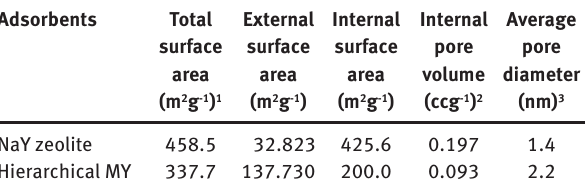
Table 2: Surface area and pore volume properties of microporous NaY and related hierarchical